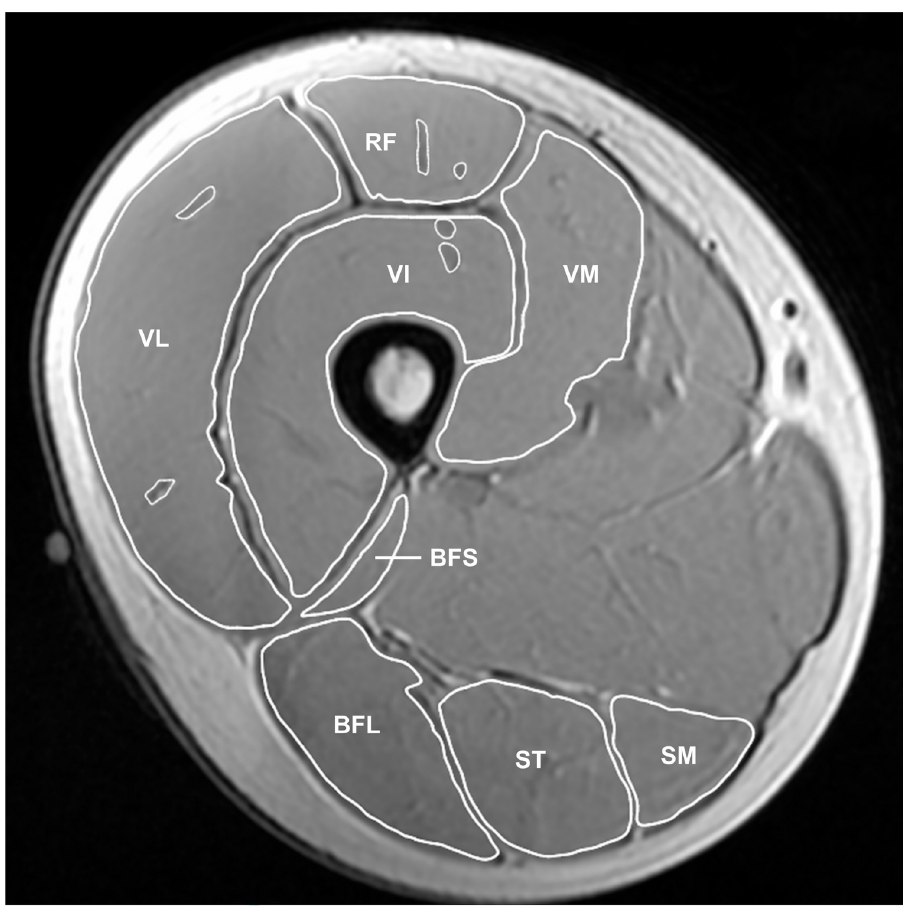
Fig 1. A typical example of 3D T1-weighted MR image at 50% of thigh length. RF = rectus femoris, VL = vastus lateralis, VM = vastus medialis, VI = vastus intermedius, BFS = biceps femoris short head, BFL = biceps femoris long head, ST = semitendinosus, SM =